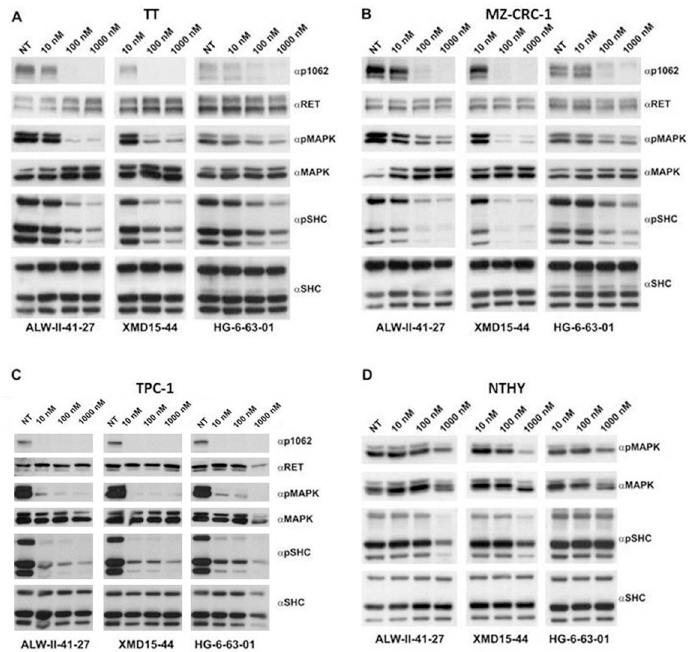
Fig 4. Inhibition of RET phosphorylation and signaling by ALW-II-41-27, XMD15-44 and HG-6-63-01 in RET mutant thyroid carcinoma cell lines. Serum-starved human TT (A) and MZ-CRC-1 (B) (MTC), TPC1 (PTC) (C), and non-transformed Nthy-ory-3-1 (NTHY) (D) cell lines were treated for 2 hr with indicated concentrations of ALW-II-41-27, HG-6-63-01 and XMD15-44. 50 μ g of total cell lysates were subjected to immunoblotting with α p1062 RET antibodies, phospho-MAPK ( α pMAPK) and phospho-SHC ( α pSHC) antibodies. The blots were normalized using anti-RET ( α RET), anti-MAPK ( α MAPK) and anti-SHC ( α SHC).